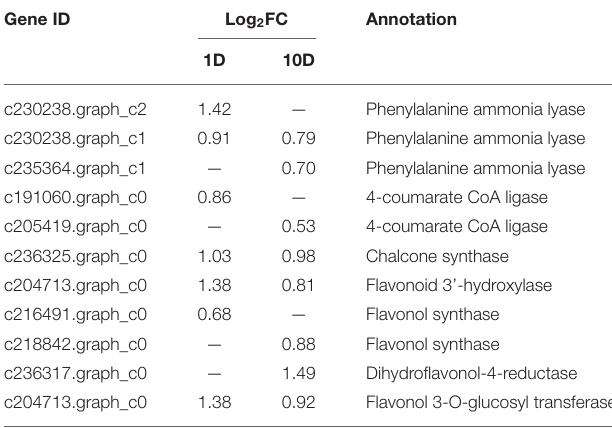
TABLE 4 | DEGs involved in anthocyanin